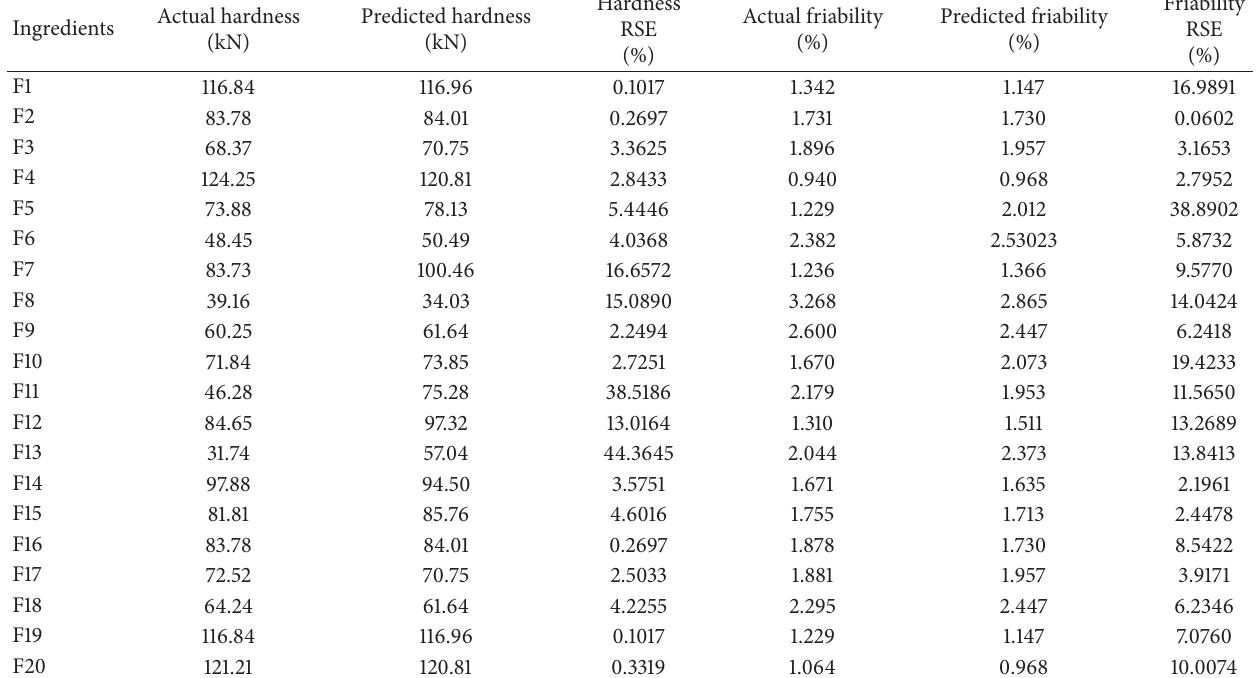
Table 3: Actual and predicted values for hardness and friability of okara tablet